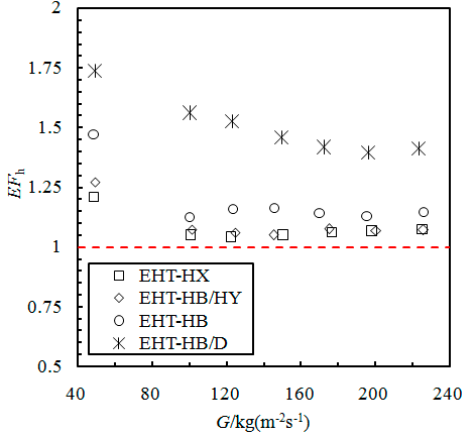
Figure 4. Comparison of enhancement factors of the evaluated enhanced tubes.